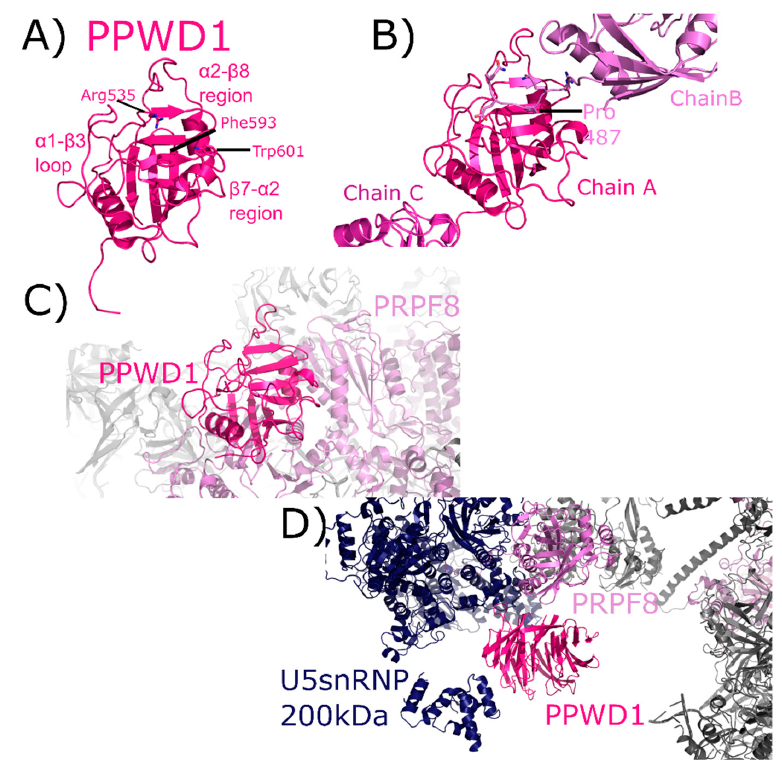
the isomerase domain of PPWD1 from the asymmetric unit of PDB ID: 2A2N is shown in cartoon representation. Selected active site residues are labeled, along with the α 1– β 3 loop and the β 7– α 2 region. In ( B ), the view is expanded to include all three PPWD1 molecules in the asymmetric unit. The proline from a neighboring molecule is shown in the active site. Modified from [30]. In ( C ), the PPWD1 neighborhood is shown in the C complex (PDB ID: 5YZG). Only PRPF8 is close enough